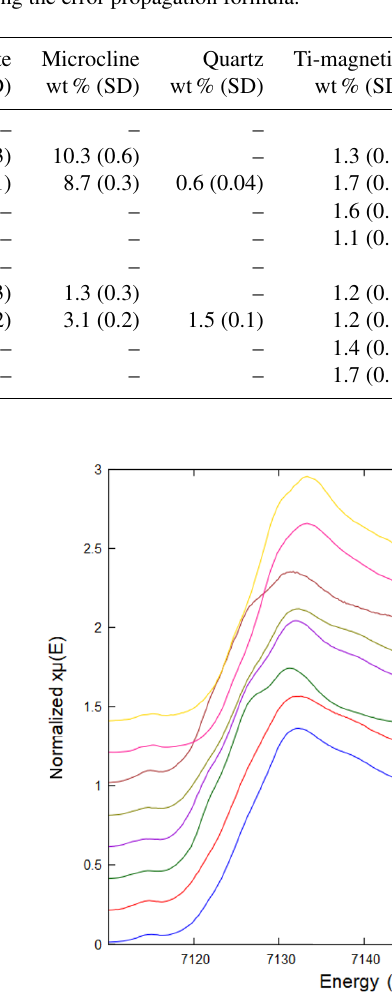
Figure 3. Fe K-edge XANES spectra of Icelandic dust, natural py- roxene from Iceland and African dust. The y axis represents an ar- bitrary